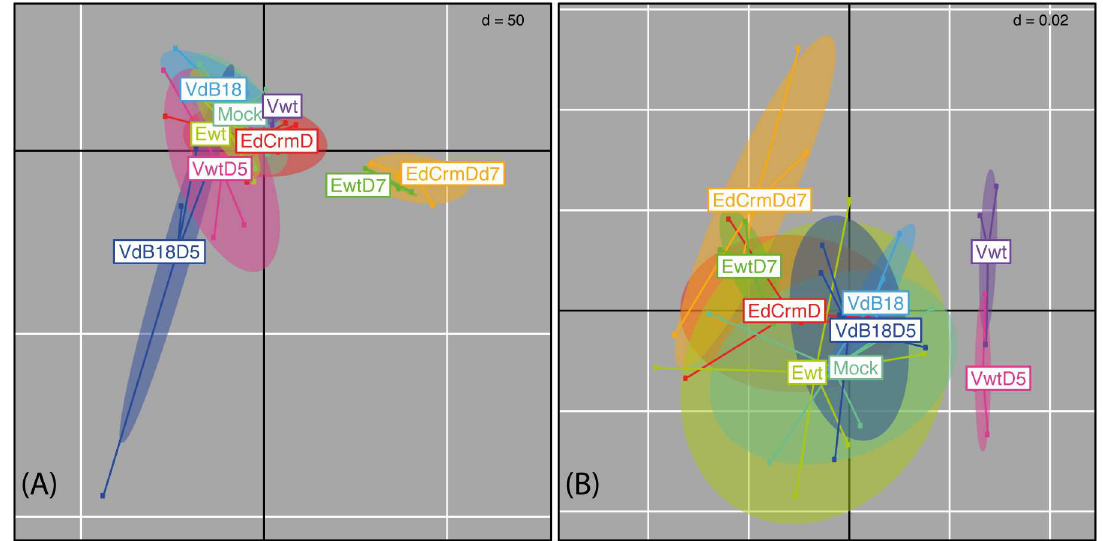
Fig 1. Exploration of trends in mucosa-associated caecalmicrobiome composition. Figures depict results from a principalcomponentsanalysis(A) and Double PrincipalCoordinates Analyses(DPCoA) (B) based on 16S marker gene profiles. The analysesordinateexperimental groups basedsolely on the per-grouprelativeabundancesof OTUs (A), or based on the phylogenetic distancesamong OTUs and per- group relative abundances of OTUs (B). Samplepoints and experimental group labels are jointly colored, and ellipsesdescribe the experimental groups’ collectivevariances.Early infectionsample groups; Mock, Vwt, Ewt, VdB18, EdCrmD. Late infectionsample groups; VwtD5, VdB18D5, EwtD7,